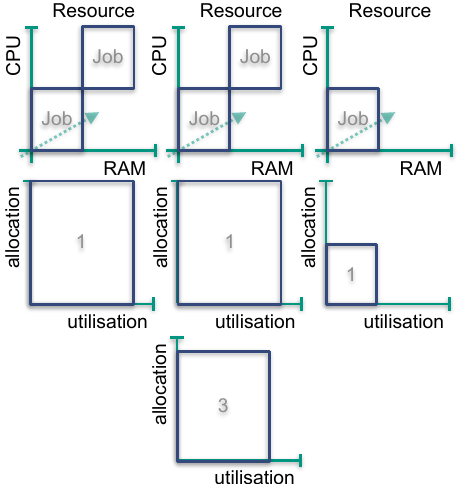
Figure 1. Compute resources and their representation by TARDIS: Compute resources are modelled as set of continuous features, e.g. a total amount of CPU cores, RAM, scratch space. Each job (or any other process) blocks a fraction of these resources for themselves. Allocation is derived from the most-used feature, signifying how much space is available for more jobs. Utilisation is derived from the least-used feature, signifying how much space is wasted by jobs. Thus, allocation and utilisation express how much and how well resources are used. Figure 2. Aggregated resources in the COBalD Pool Model: A Pool represents several resources by their combined allocation, utilisation and supply. The appearance is yet again that of a resource, but intentionally hides